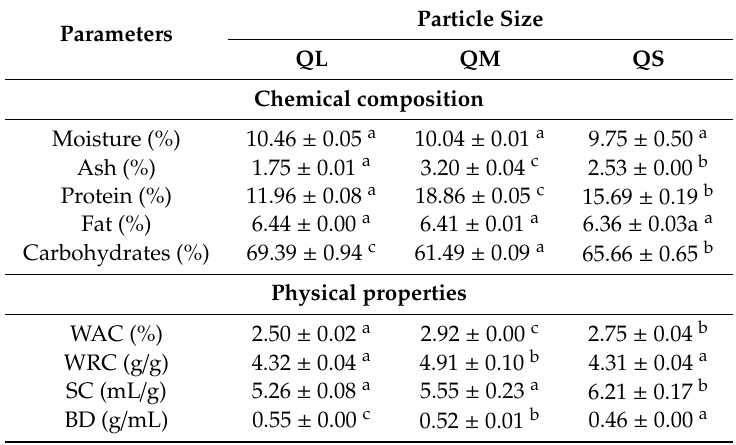
Table 2. Chemical composition and physical properties of the quinoa flours fractions: large particle size (QL), medium particle size (QM) and small particle size